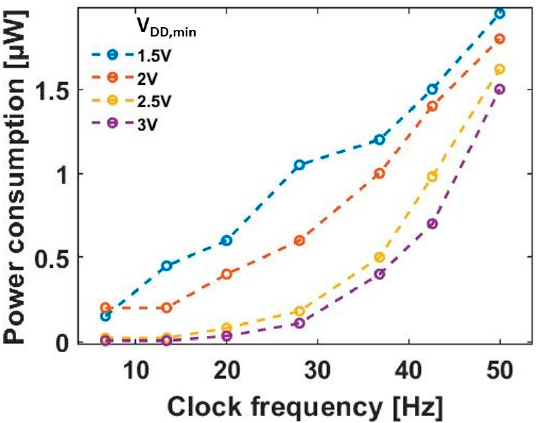
Figure 6. Power consumption of the D flip-flop (CD4031B) vs. clock frequency.